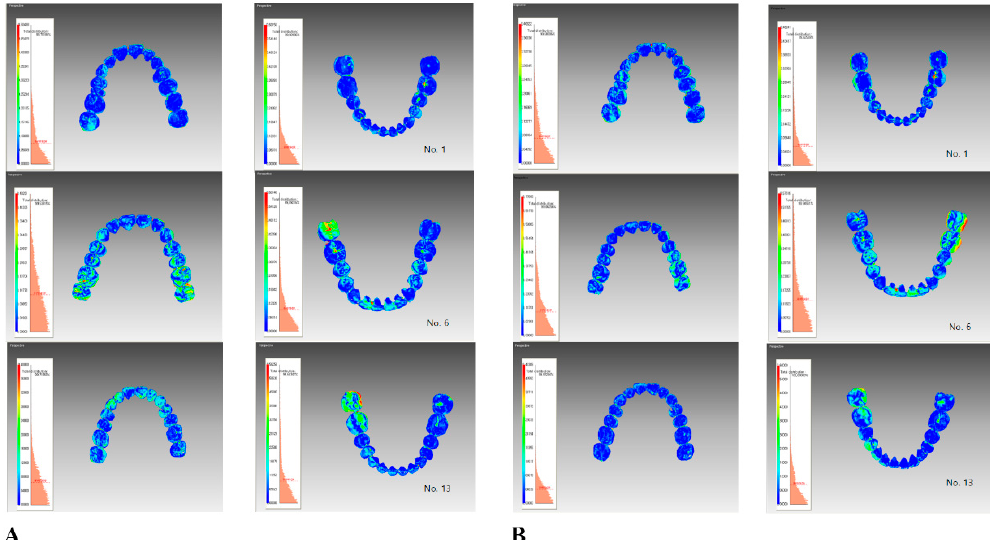
Figure 3. Color histograms showing the deviations between the intraoral scan and models after best-fit alignment. ( A ), Surface deviation between the iTero scan and model scan. ( B ), Surface deviation between the TRIOS scan and model scan. Table 1. Surface deviations between each intraoral scan and model scan (unit: mm). iTero vs. Model